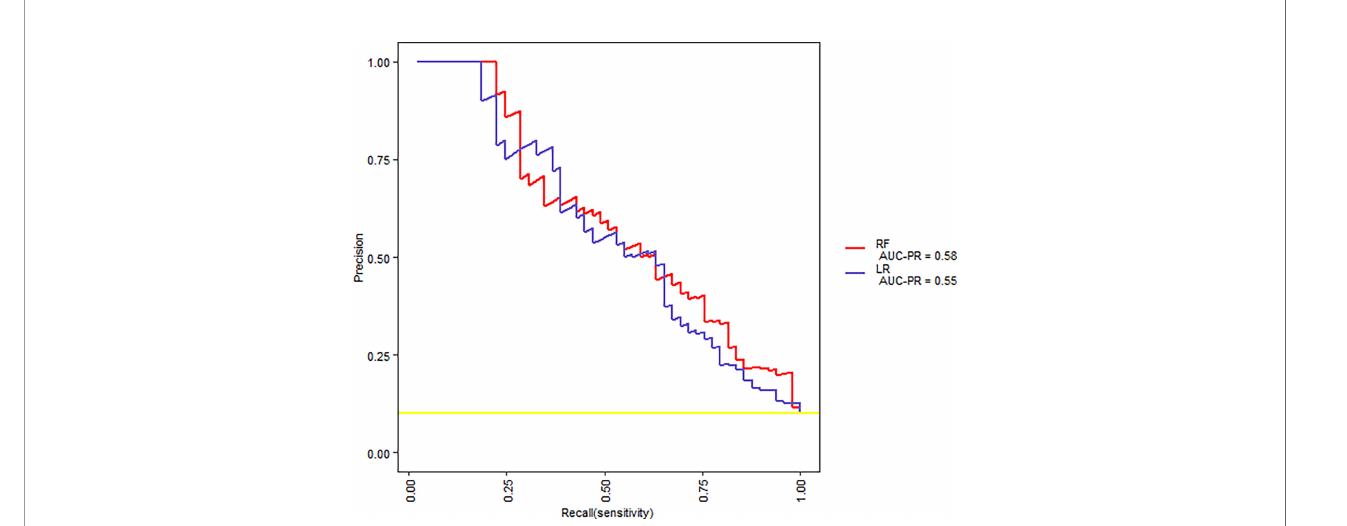
FIGURE 4 | The precision-recall curves for RF and LR models for tenfold cross-validation on the training set.